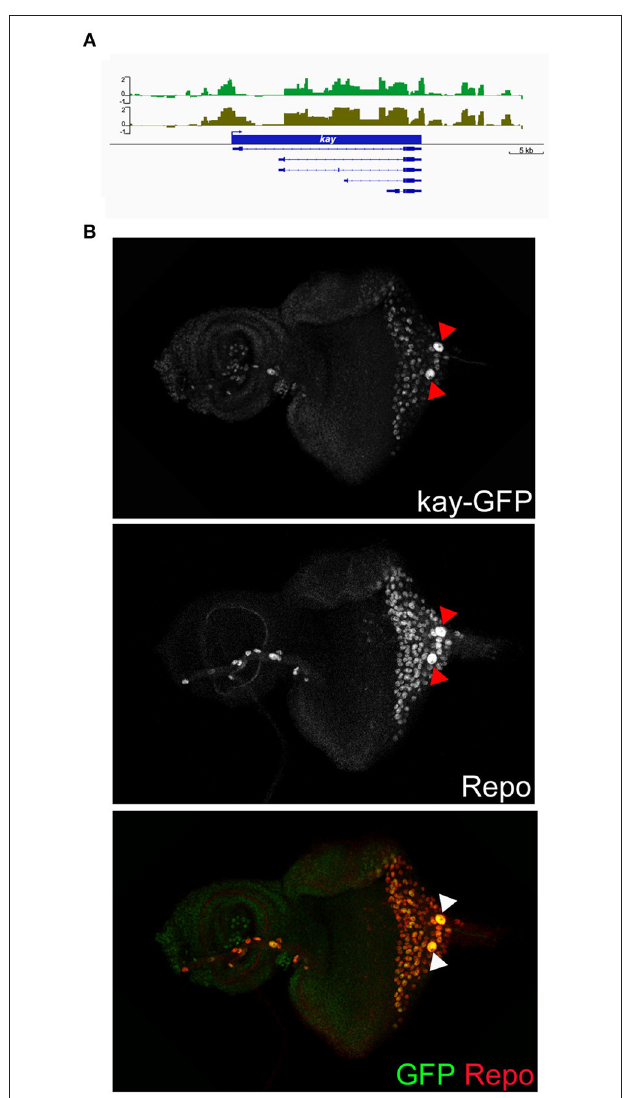
FIGURE 3 | Characterization of Dam-Pol II-bound kay . (A) Dam-Pol II occupancy in the kay locus. Both biological replicates are shown in light and dark green. Scale bars on the y -axis represent the log 2 ratio change between Dam-Pol II and Dam samples. (B) Expression of GFP-tagged Kay protein. Larval eye imaginal disc stained for Kay protein (GFP staining, green) and glial nuclei (Repo staining, red). Red and white arrowheads indicate the carpet